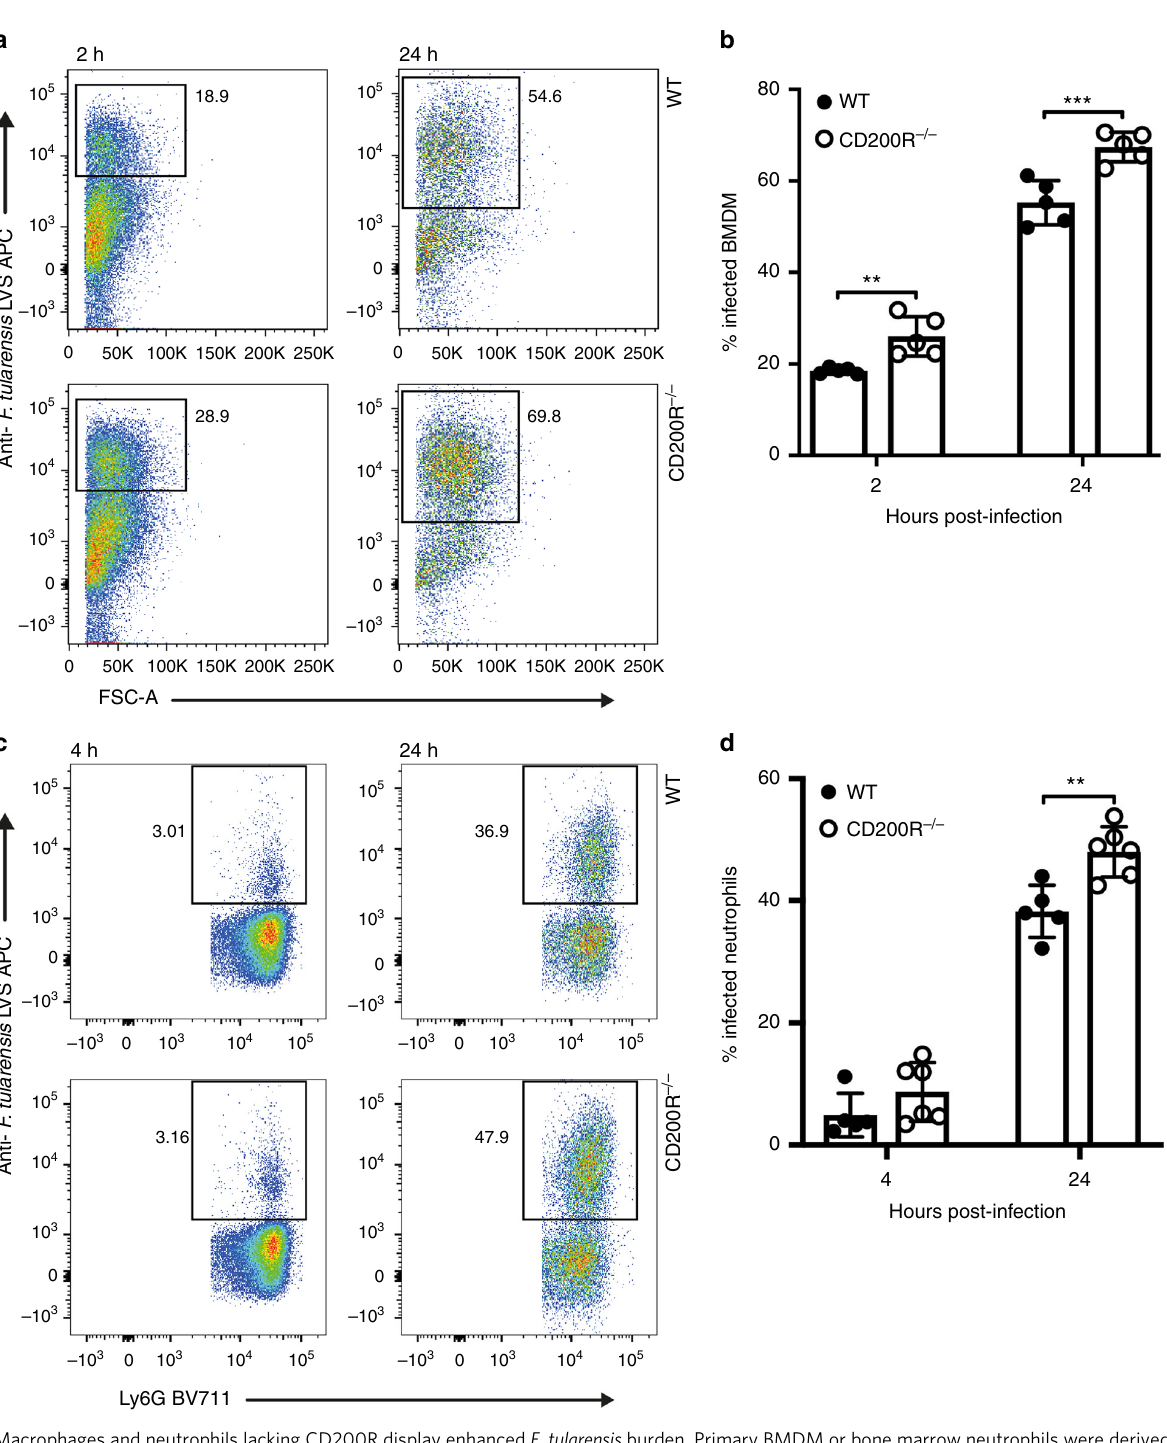
Fig. 1 Macrophages and neutrophils lacking CD200R display enhanced F. tularensis burden. Primary BMDM or bone marrow neutrophils were derived from wild-type or CD200R − / − mice and infected with F. tularensis LVS MOI 100. a Representative dot plots of F. tularensis -infected BMDM at 2 and 24 h p.i. Cells were labelled with an anti- F. tularensis LVS antibody and samples were pre-gated on live, single cells. b Quanti fi cation of F. tularensis levels in BMDM at 2 and 24 h p.i. c Representative dot plots of F. tularensis -infected neutrophils at 4 and 24 h p.i. Samples were pre-gated on live, single, CD11b + Ly6G + cells. d Quanti fi cation of F. tularensis levels in neutrophils at 4 and 24 h p.i. Data represent two independent experiments and is shown as mean ± SD ( n = 5 – 6). Statistical analysis was performed using two-way ANOVA (* p < 0.05, ** p < 0.01, *** p <